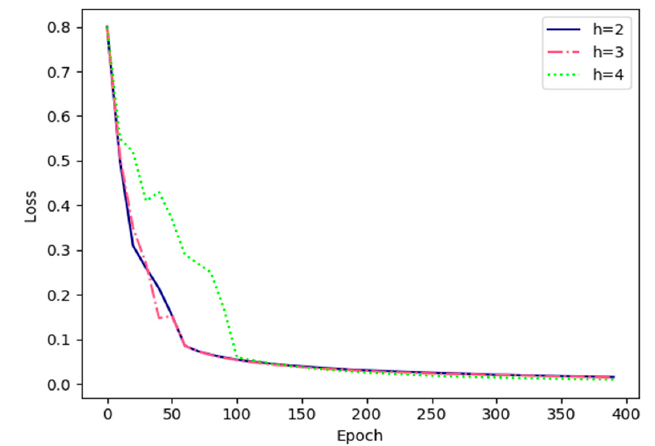
Figure 10. Variation of pre-training loss according to the number of epochs to fix the number of network hidden layer.